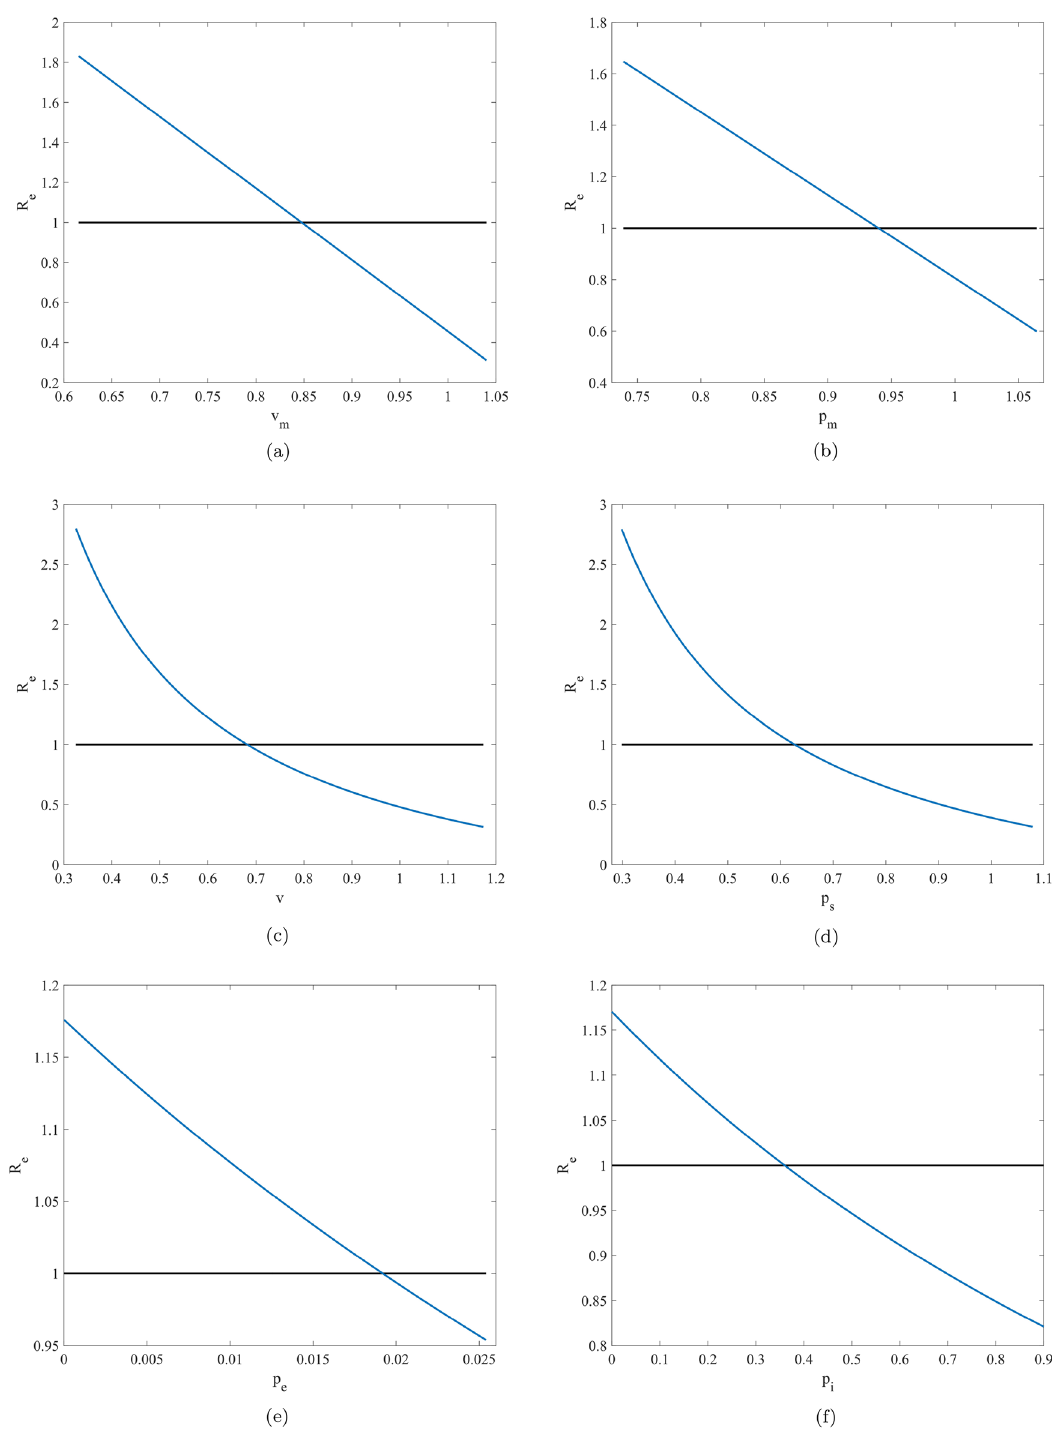
Figure 7. The effect of the critical parameters v m , p m , v , p s , p e and p i on the effective reproduction